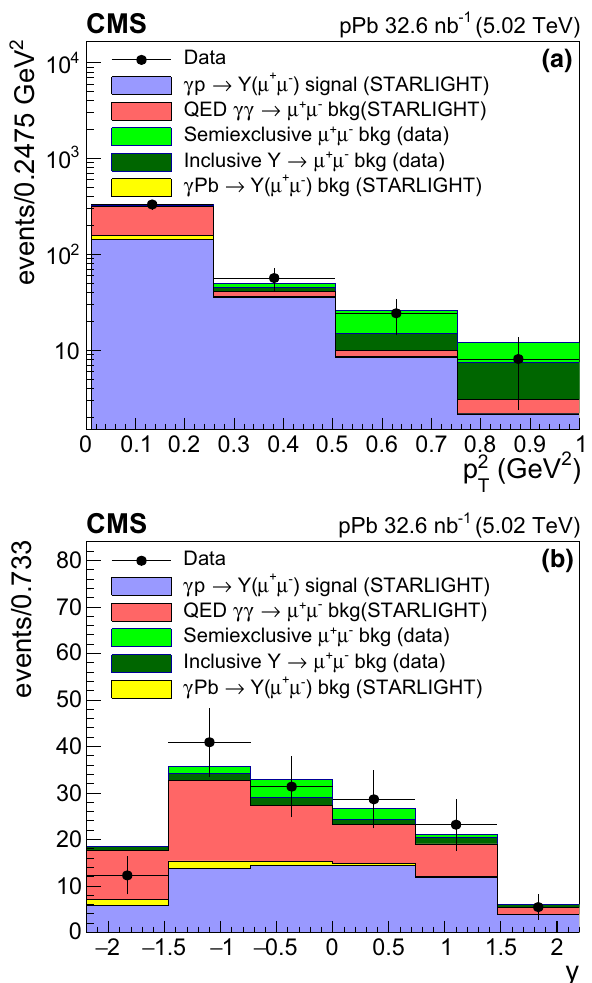
Fig. 3 Distributions of the a transverse momentum squared p 2 rapidity y of exclusive muon pairs with invariant mass 9 . 1 < m μ + μ − < 10 . 6 GeV after all selection criteria have been applied. Both distri- butions are compared to the expectations of signal and background contributions discussed in the text